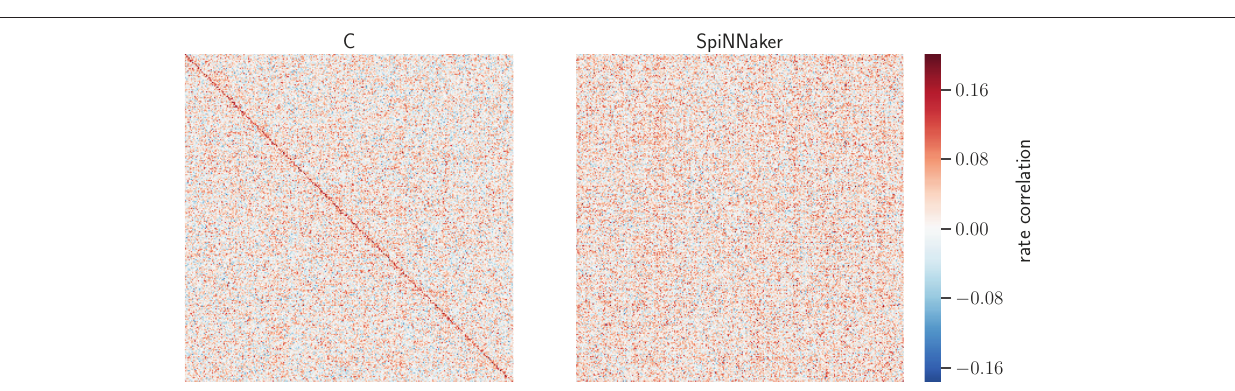
significance of the results of the C and SpiNNaker simulation